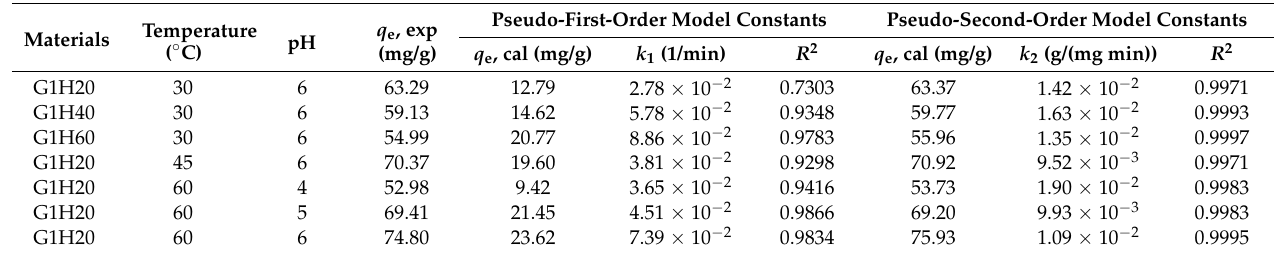
Table 1. Pseudo-first-order and pseudo-second-order kinetic model constants for Cu(II) adsorption onto PGA-AP nanoparticles.